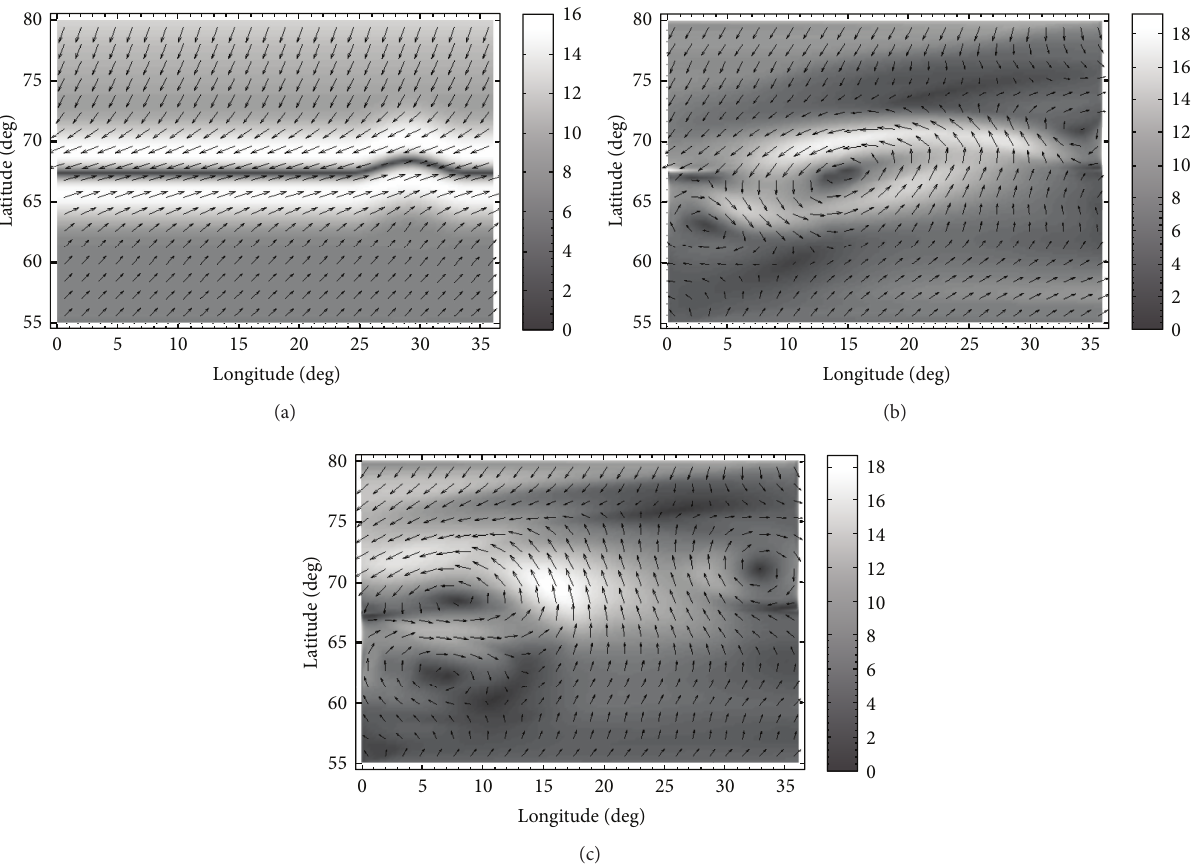
Figure 3: The distributions of horizontal component of the air velocity at the altitude of 600 m, assigned at the initial moment (a), computed 20 hours after the beginning of calculations (b) and computed 40 hours after the beginning of calculations (c). The results are obtained for the third initial configuration of the arctic front, with the fields of the module of the horizontal velocity being approximately symmetric relatively to the centerline of the arctic front. The degree of shadowing of the figures indicates the module of the velocity in m/s.